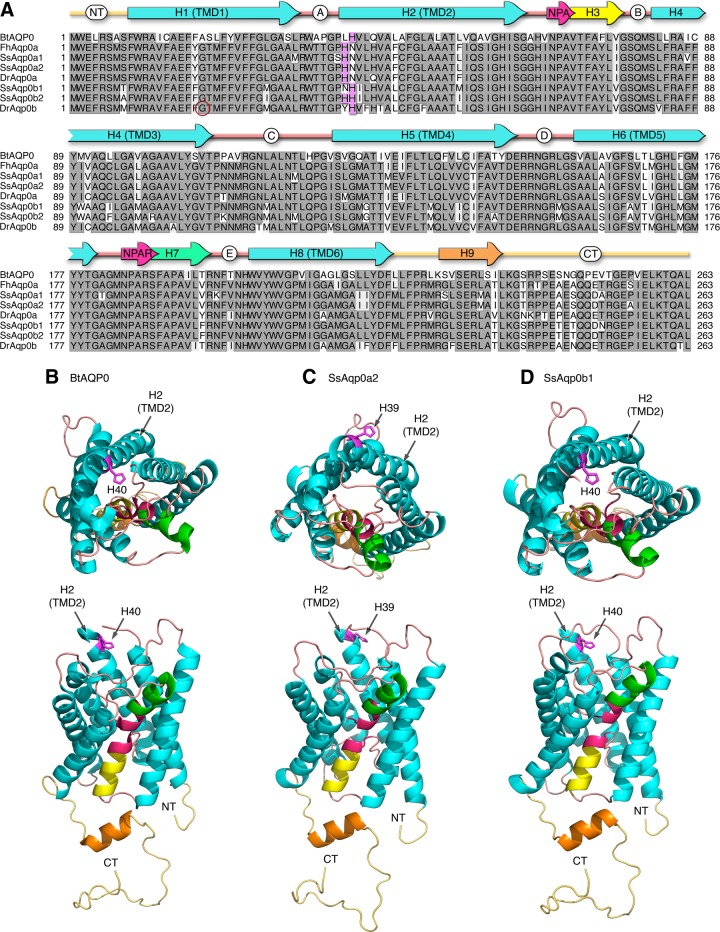
Structural analysis of tetrapod and teleost AQP0. A) Amino acid alignment of Atlantic salmon and representative teleost Aqp0 sequences in relation to bovine AQP0. Fully conserved residues are boxed in dark gray, whereas the His residue involved in pH sensitivity is shaded in magenta. The zebrafish allelic variant at position Gly19 is circled in red. Conserved Asn-Pro-Ala (NPA) motifs (pale red arrows) are highlighted with α-helical regions shown for TMDs 1–6 (light blue arrows), hemihelices 3 (yellow arrow), 7 (green arrow), and 9 (orange arrow), intra- and extracellular loops (A–E; pink lines) with the N (NT) and C (CT) termini (palid orange lines). Taxa as follows: Bt, Bos taurus; Fh, Fundulus heteroclitus; Ss, Salmo salar; Dr, Danio rerio. B–D) Extracellular (upper) and lateral (lower) views of bovine AQP0 (B) and Atlantic salmon Aqp0a2 (C) and Aqp0b1 (D) are rendered with MacPymol.